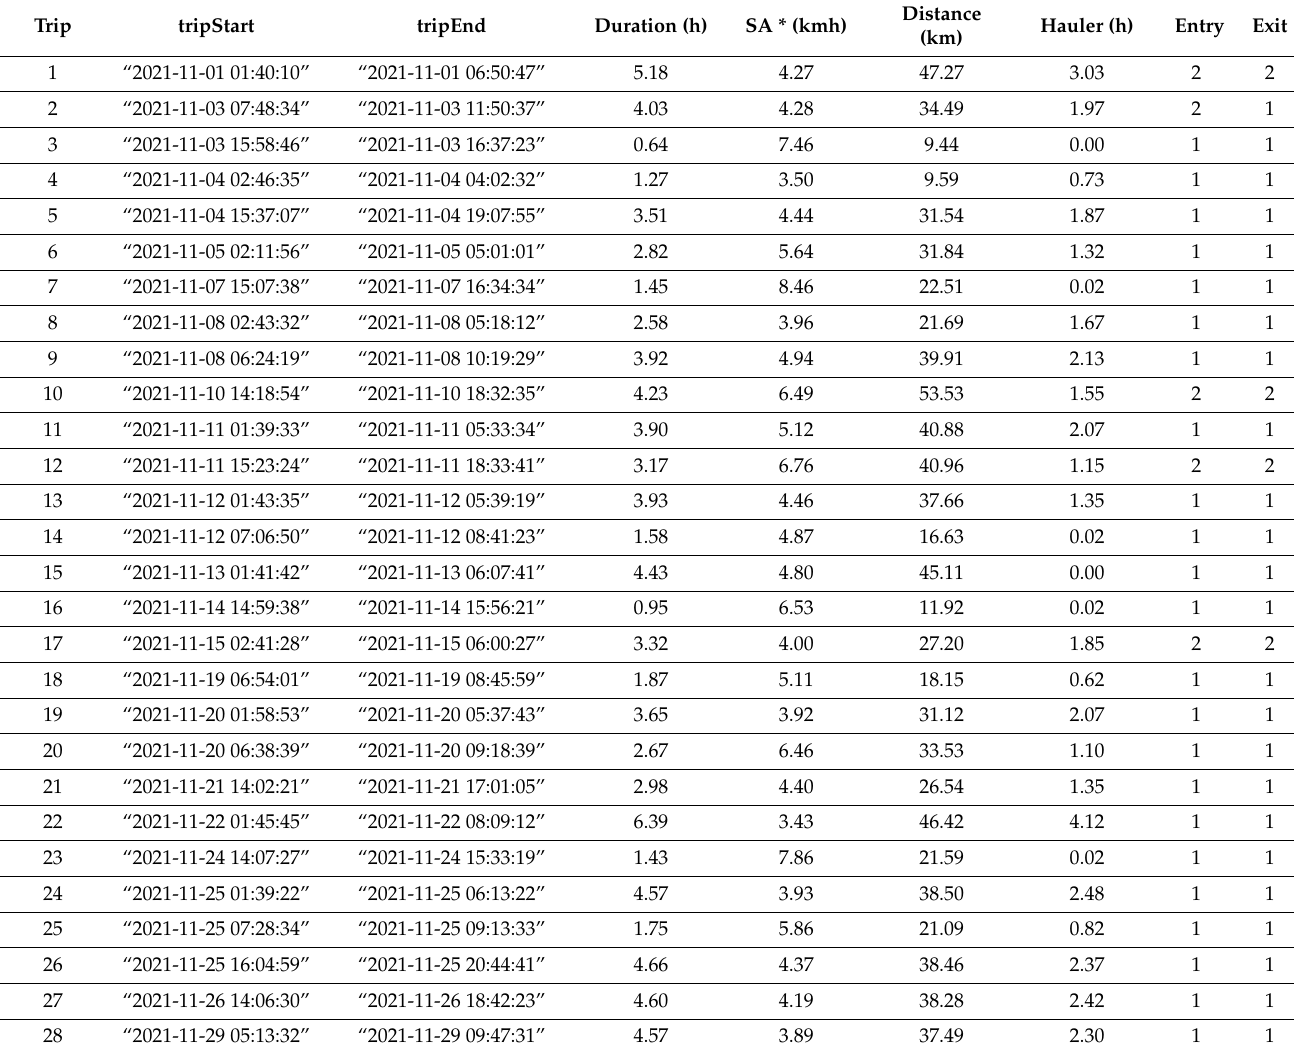
Table 2. Identified trips and related